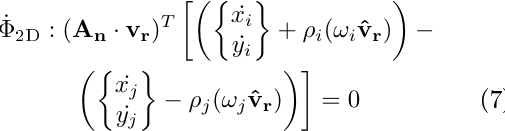
(a) Base ( ρ b ), working and addendum circles. Path of con- tact is yellow and the green line is tangent to the two base circles (see e.g. Klit et al. (2009)).